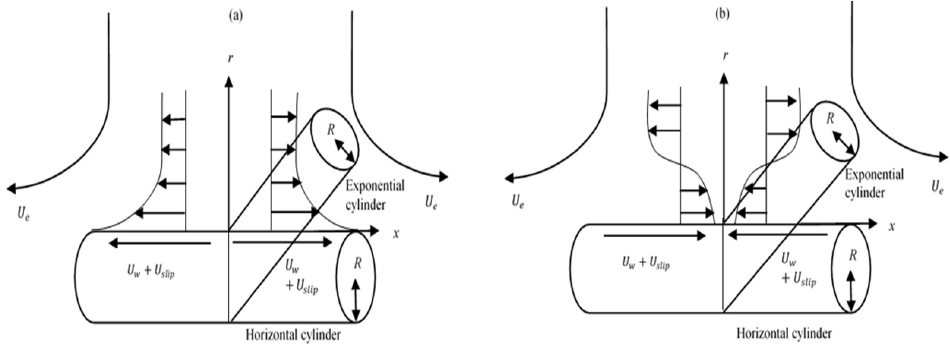
Figure 1. Physical model and coordinate system of ( a ) stretching cylinder and ( b ) shrinking cylinder.